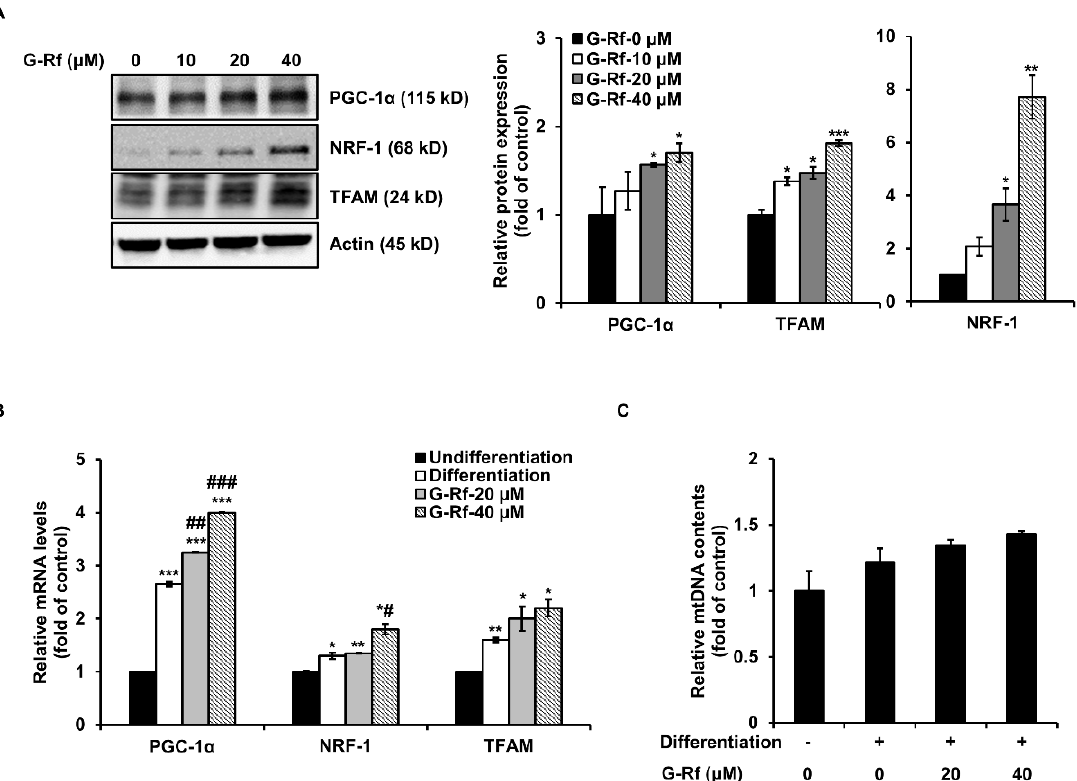
Figure 4. G-Rf upregulates the levels of markers associated with mitochondrial biogenesis in C2C12 myotubes. ( A ) Protein and ( B ) mRNA levels of PGC-1 α , NRF-1, and TFAM were measured using Western blotting and qRT-PCR, respectively. ( C ) Total mtDNA was investigated using qRT-PCR. Data are expressed as the mean ± standard deviation ( n = 3). * p < 0.05, ** p < 0.01, *** p < 0.005 compared to untreated myoblasts. # p < 0.05, ## p < 0.01, ### p < 0.005 compared to untreated myotubes.